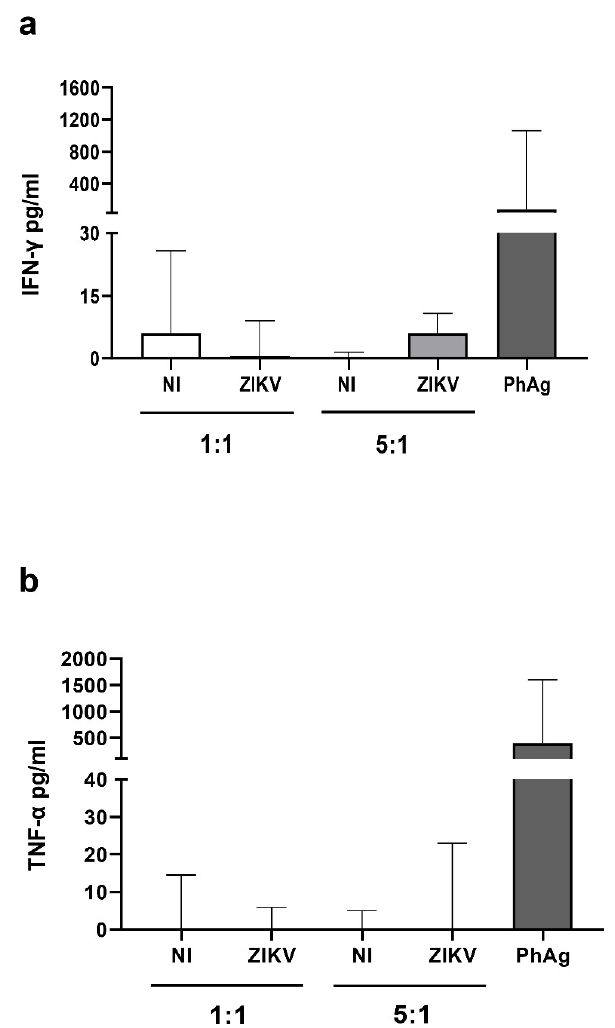
Figure 3. ZIKV-infected A549 cells did not induce IFN- γ and TNF- α production by expanded V δ 2 T-cells. ( a , b ) Expanded V δ 2 T-cells were cultured overnight with mock (white bars) or ZIKV-infected A549 cells (grey bars) cells, at 1:1 and 5:1 ratios, or stimulated with PhAg (IPH1101 3 µ M) as positive control. ( a , b ) After 18 h, culture supernatants were collected and IFN- γ (n-8) and TNF- α (n-5) were quantified by ELISA assays. Data were subtracted of the background (expanded V δ 2 T-cells alone). Data were represented as median + interquartile range.